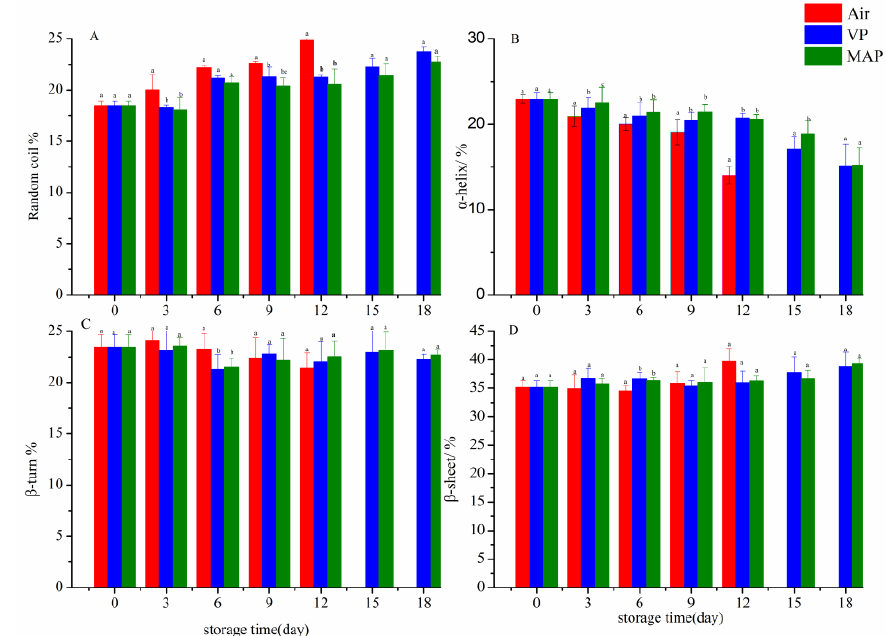
Figure 7. Changes in secondary structure contents of grouper protein during refrigerated storage ( A : the change in the random coil content under di ff erent treatments, B : the change in the α -helix content under di ff erent treatments, C : the change in the β -turn content under di ff erent treatments, D : the change in the β -sheet content under di ff erent treatments). (Air: air packaging; VP: vacuum packaging; MAP: modified atmosphere packaging).